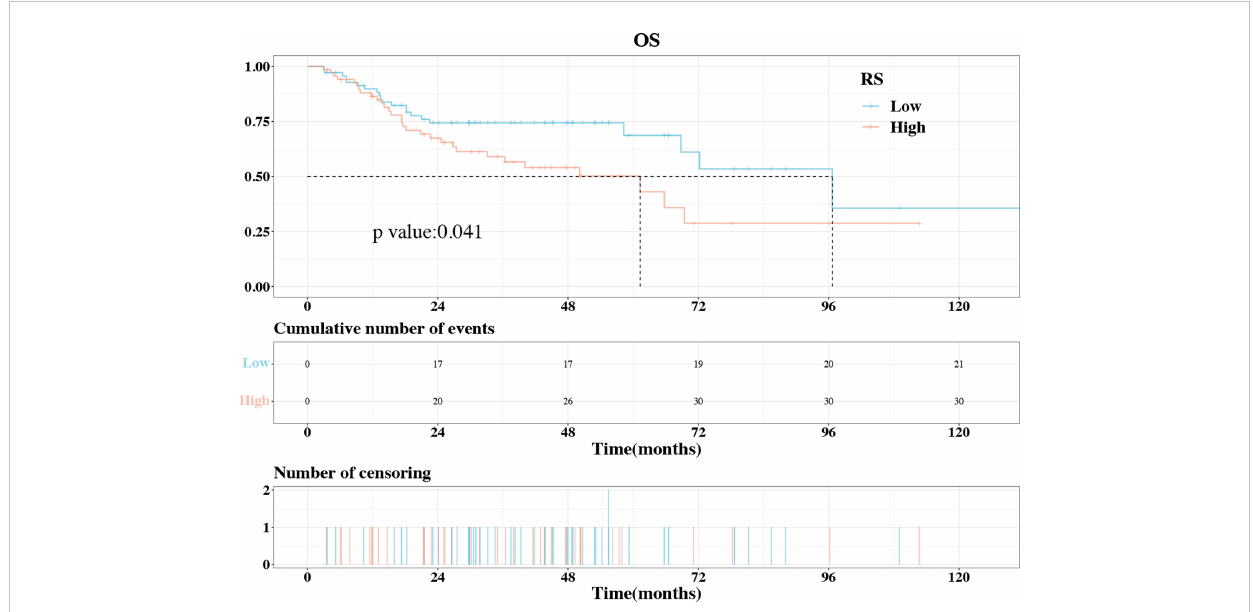
FIGURE 9 The KM plot of OS in the high rad-score and low rad-score groups. The OS was signi fi cantly higher in the low rad-score group compared to high rad-score group. KM, Kaplan – Meier; OS, overall